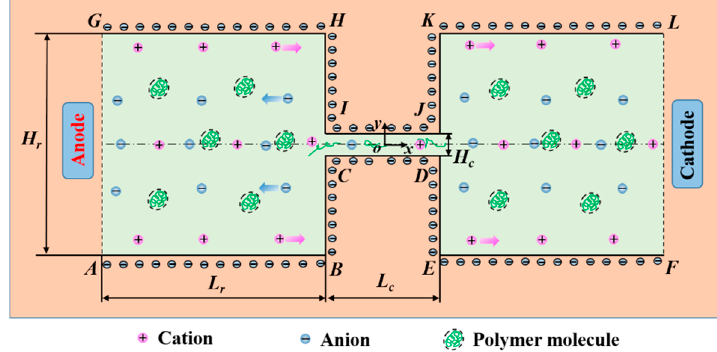
Figure 1. Schematic diagram of a constriction microchannel connecting two reservoirs at both ends. The solid walls of reservoirs and the constriction channel are negatively charged, and an electric field is imposed by applying a potential difference between anode and cathode positioned in two fluid